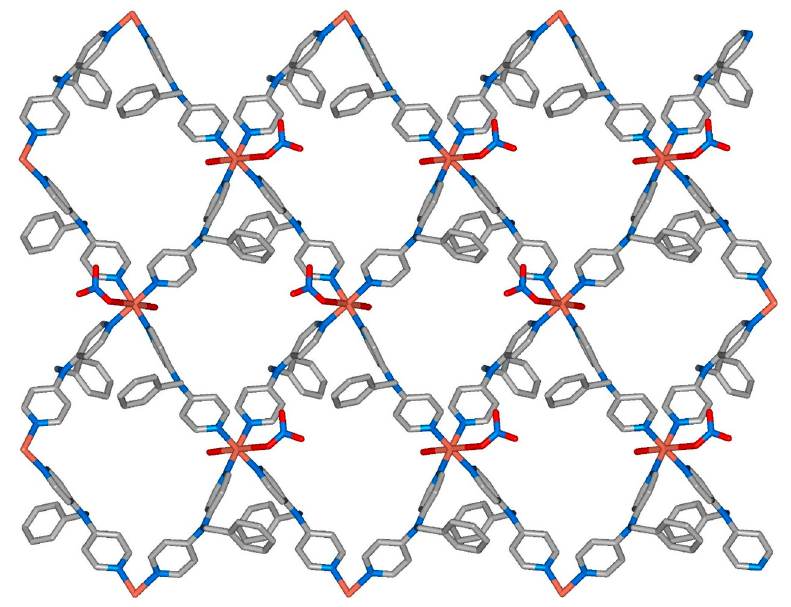
Figure 6. Extended 2D structure of polymer 2 formed by the coordination of the Cu(II) ions and bpba ligands.